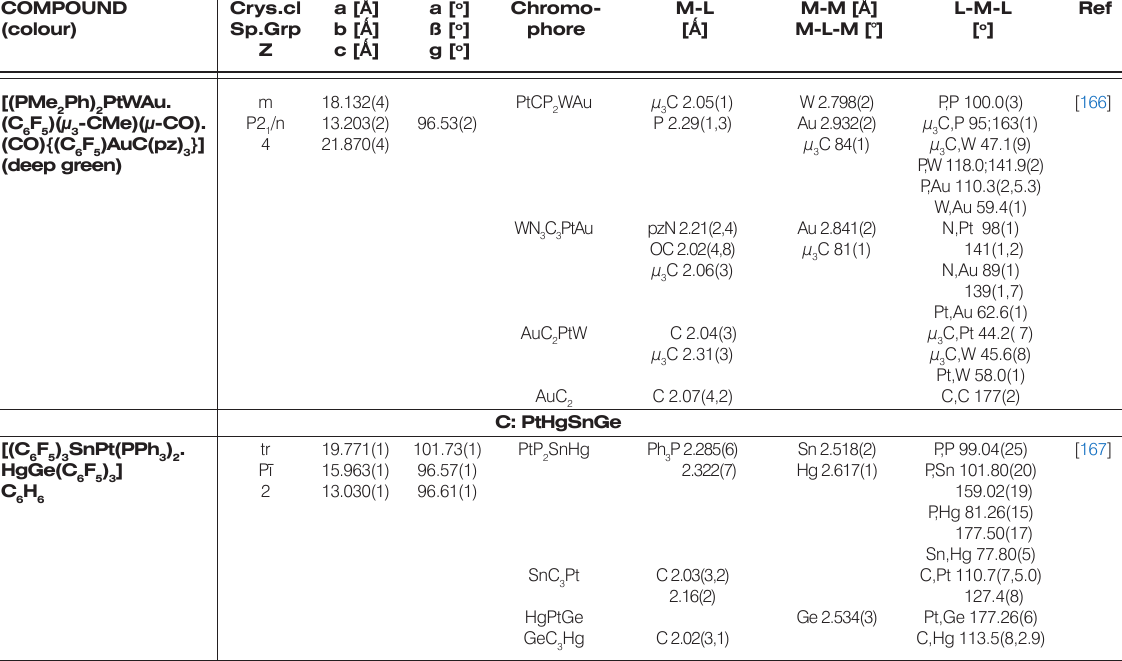
Footnotes: a. Where more than one chemically equivalent distance or angle is present, the mean value is tabulated. The first number in parenthesis is the e.s.d., and the second is the maximum deviation from the mean. b. The chemical identity of the coordinated atom or ligand is specified in these columns. c. The four-membered metallocyclic ring.